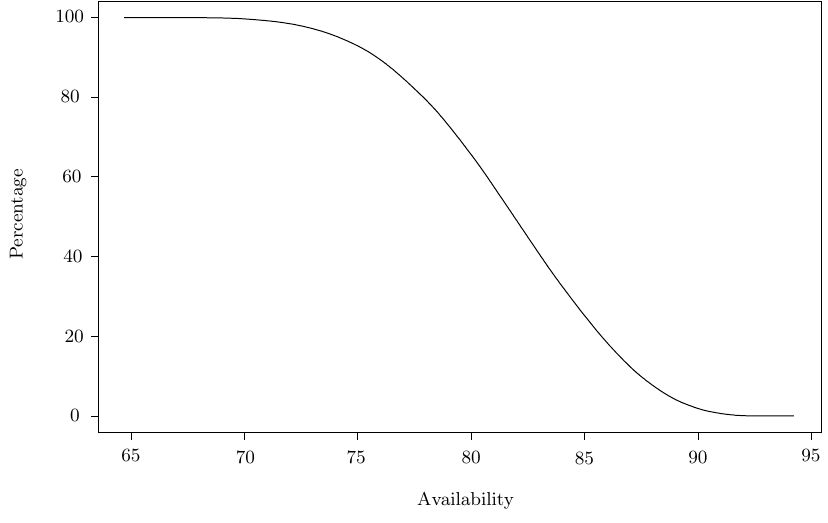
Figure 6: Percentage design space above percentage availability